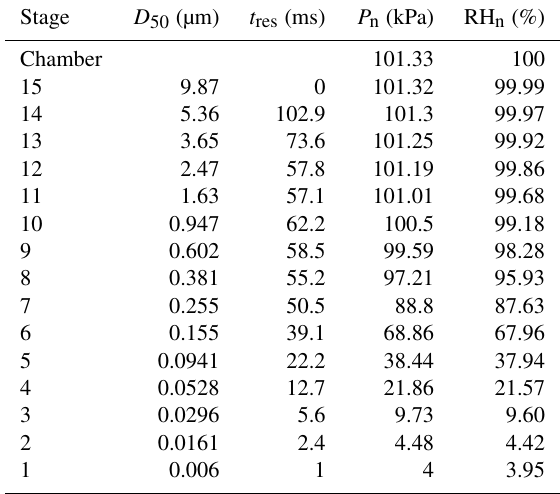
Table 2. ELPI cut point diameter ( D 50 ; µm), residence time (ms), pressure (kPa), and calculated relative humidity (%) for each stage, assuming 100% RH and 101.33kPa in reaction